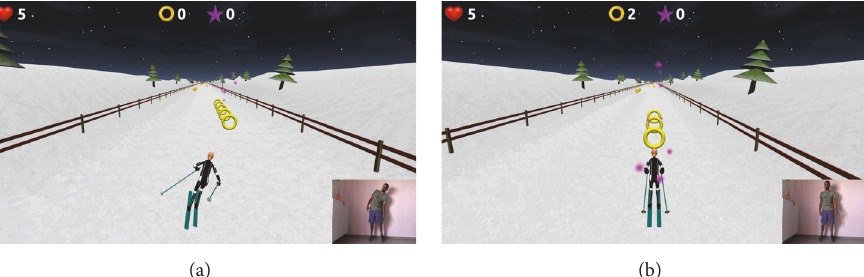
Figure 12: Slope Creep game. (a) The main screen shows a sample screenshot from the lean to the right animation performed by the avatar shown in the main screen. The animation is triggered by successfully detecting the “Lean Torso” to the right gesture executed by the human actor shown in the insert in the bottom right corner of the screenshot; (b) as a result, the avatar is now aligned to the line of rings to be